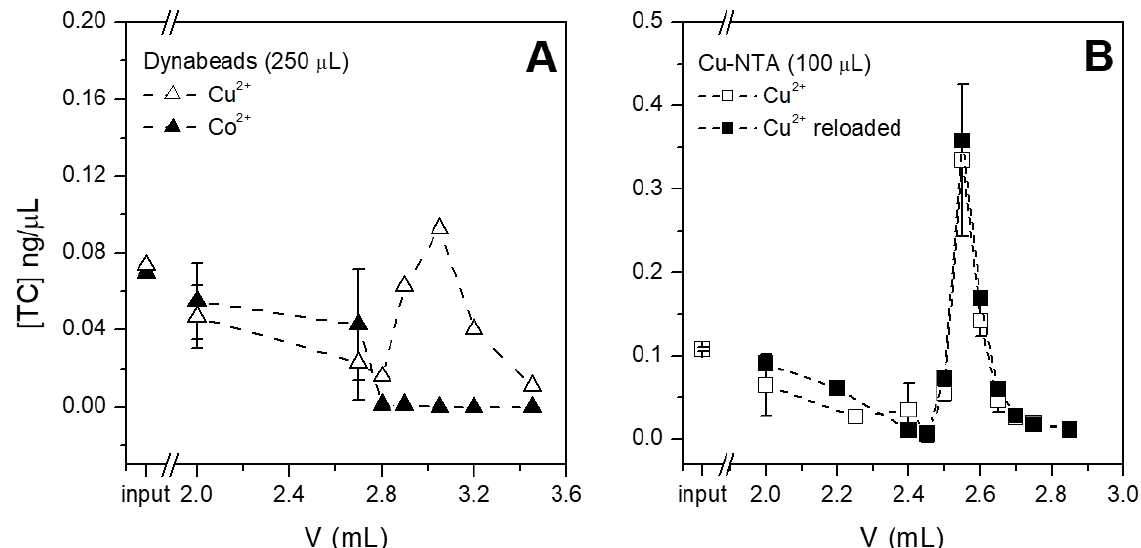
Figure 4. Tetracycline capture and release from ( A ) Dynabeads loaded in the 250 µL chambers without further treatment, i.e., exposing Co 2 + (black triangles) or re-loaded with Cu 2 + (white triangles); and ( B ) Cu-NTA beads in 100 µL chambers without treatments (Cu 2 + , white squares) or reloaded (black squares). Error bars represent the standard